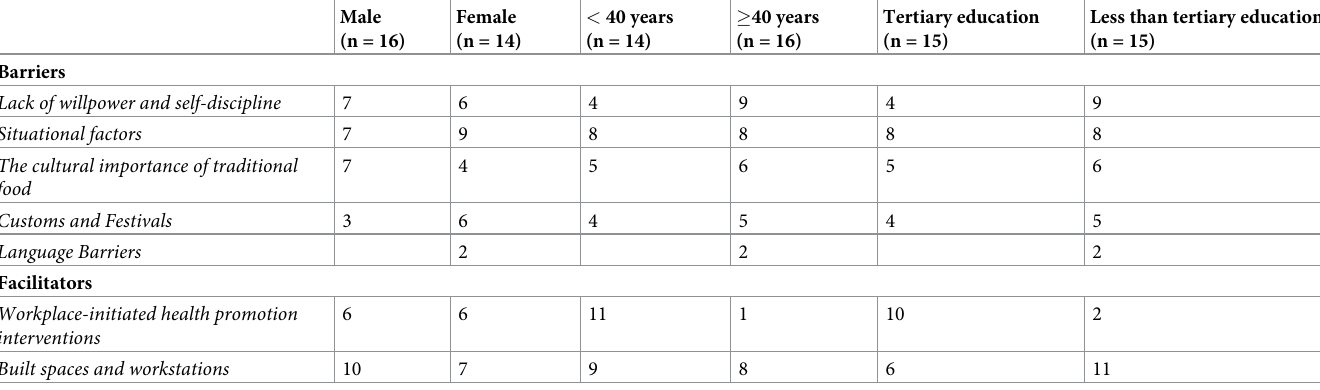
Table 2. Barriers and facilitators endorsed by respondents across socio-demographic groups